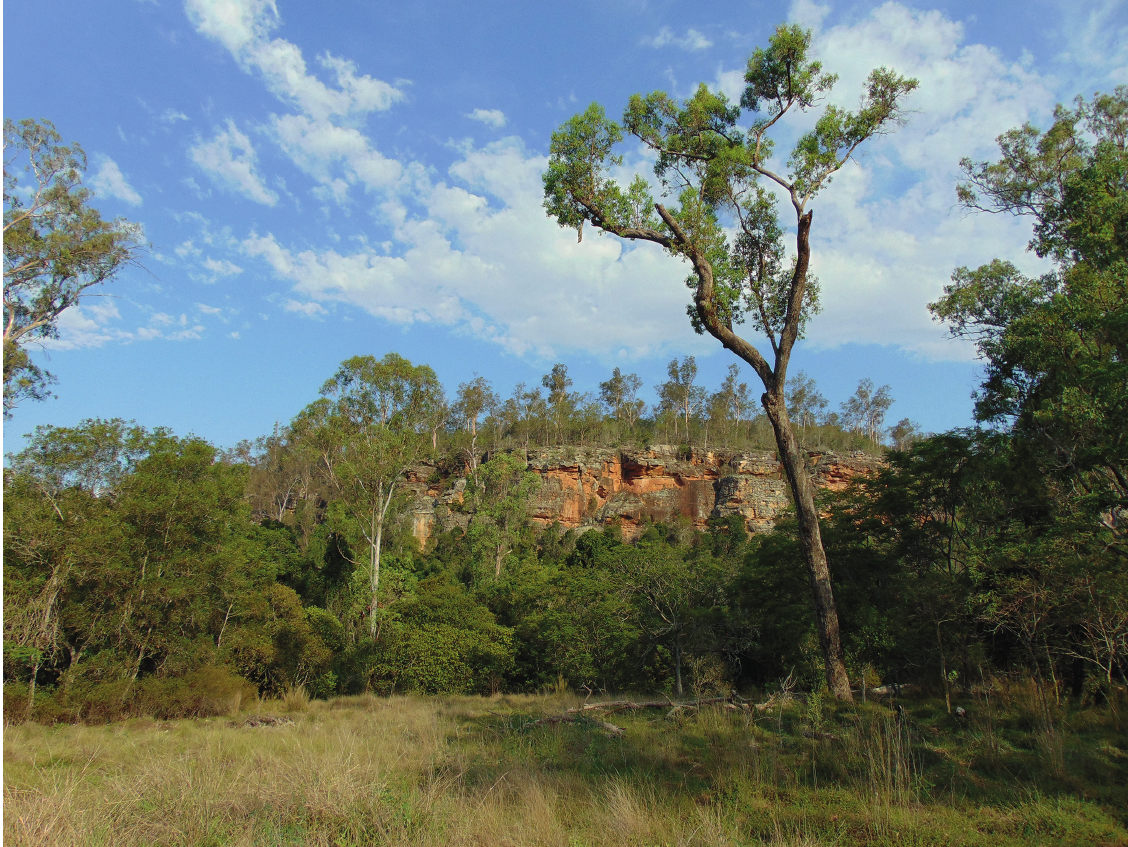
Fig. 5. Habitat of Cleotyche ( Cleotyche ) christinae sp. nov. in Cania Gorge National Park, 13 Dec.